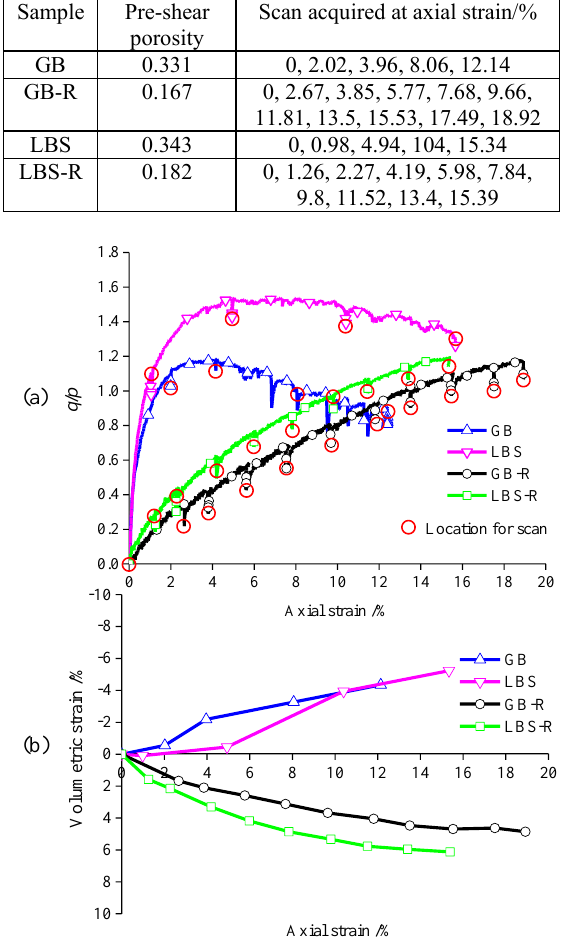
Table 1. Summary of test conditions of the samples